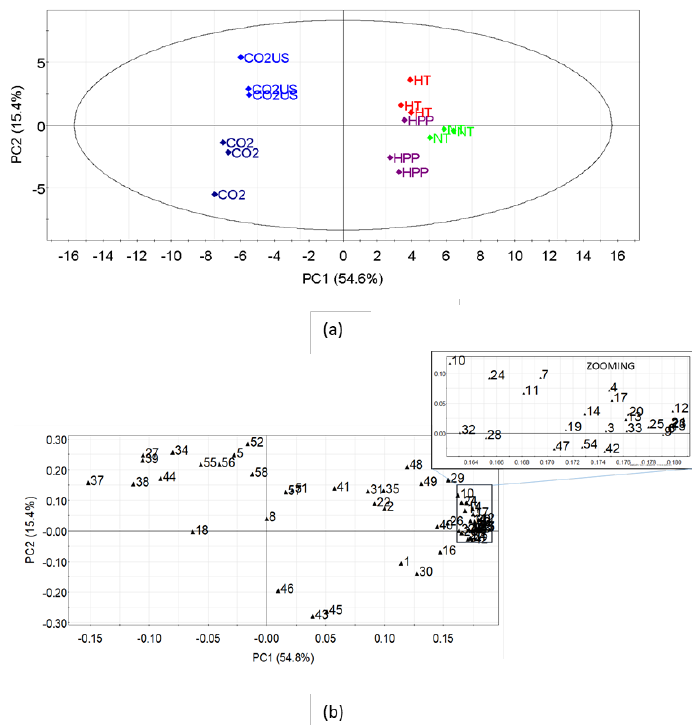
Figure 3. Principal component analysis (PCA) of SPME / GC-MS data for juices at t 0 . ( a ) Score plot of the first two components on standardized results. ( b ) Loading plot of the first two components on standardized results; numbers correspond to the volatile compounds reported in Table 3.